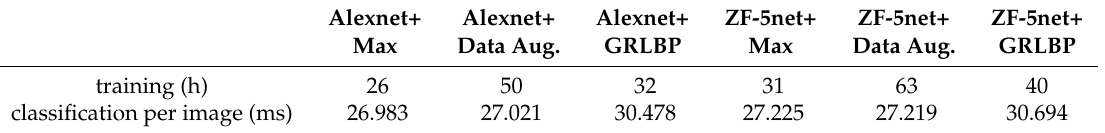
Table 5. The training and classification time of different pooling methods and data